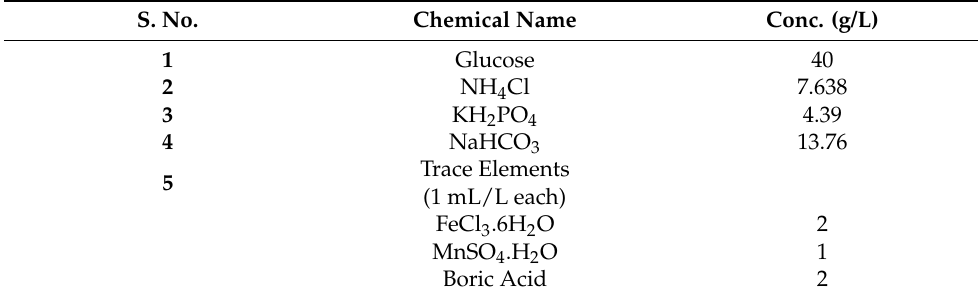
Table 2. Synthetic wastewater composition.